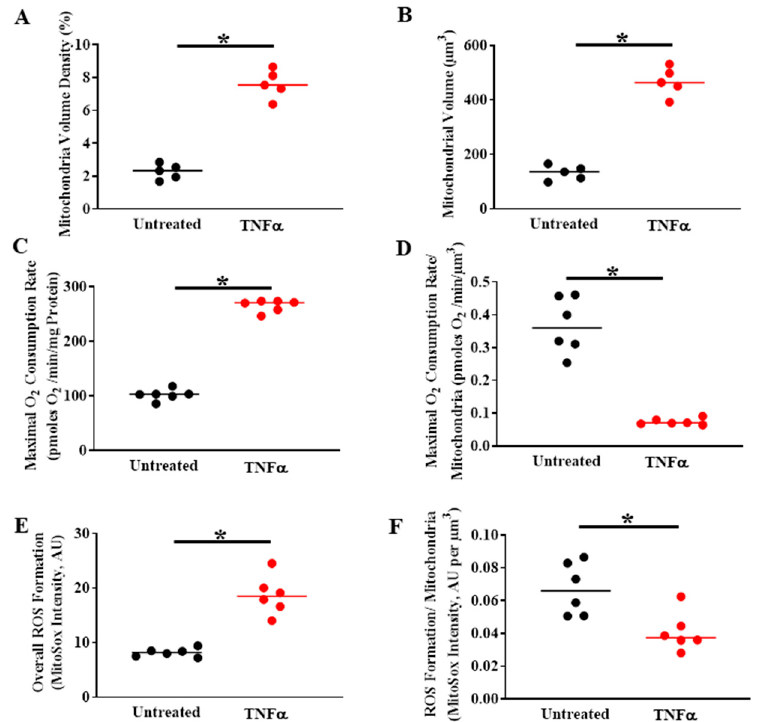
Figure 6. In human ASM cells, TNF α exposure (20 ng/mL, 24 h) increases ( A ) mitochondrial volume density per cell and ( B ) and the total mitochondrial volume and ( C ) overall maximum mitochondrial O 2 consumption rate (measured using Seahorse) ( D ) maximum O 2 consumption rate when normalized for mitochondrial volume density, O 2 consumption rate per mitochondrion (i.e., normalized for) is reduced; ( E ) overall ROS formation measured using MitoSox; ( F ) however, when normalized for mitochondrial volume density, this increase in ROS is mitigated. (* denotes a significant difference between TNF α treated and untreated control groups; p < 0.05; t -test; cells were dissociated from ASM samples from n = 5 patients and divided into TNF α treated and untreated control groups). All data are presented as scatter plots with the lines indicating the mean values. These figures are modified from presentations of previously reported results [4].